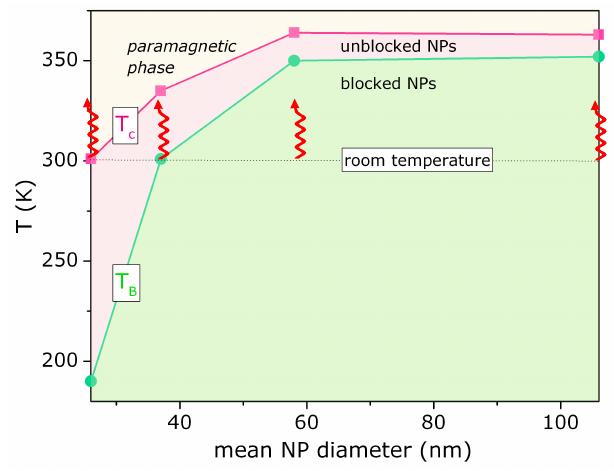
Figure 5. Phase diagram based on blocking and critical temperatures as a function of mean NP diameters for the samples prepared. Note the different regions in which the samples are heated up, upon hyperthermia experiment: region with magnetically blocked NPs (bigger NPs), paramagnetic NPs (smaller NPs) and magnetically unblocked NPs (intermediate size).